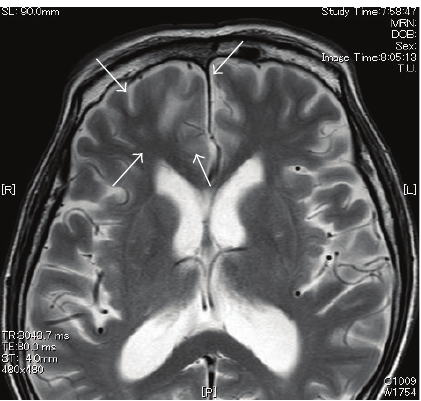
Figure 7: MR image (T2WI) obtained one month after beginning